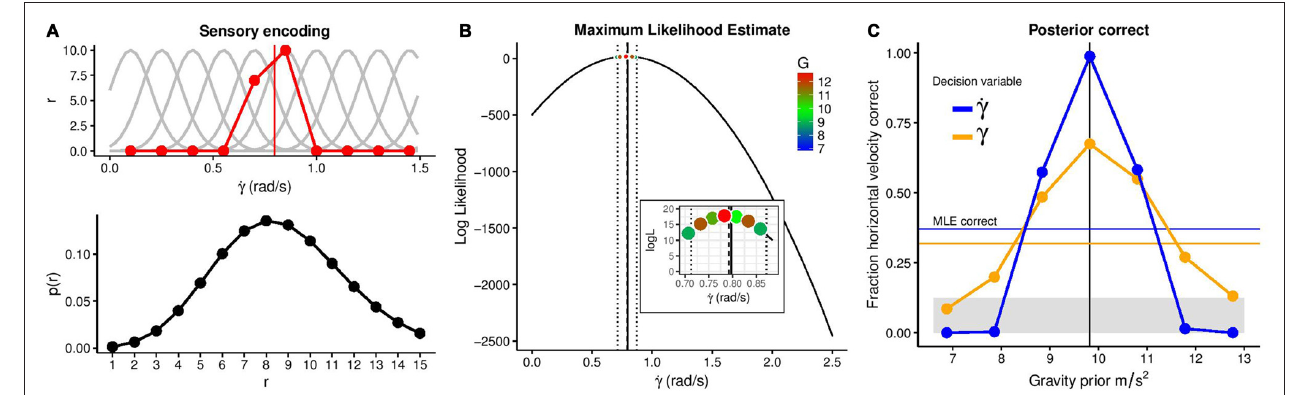
FIGURE 3 | Illustration of the benefits of a strong gravity prior. (A) The upper panel shows simulated tuning curves of neurons specialized for different rates of change of the elevation angle (light gray) together with neurons’ responses to the stimulus value of ˙ γ = 0.797 rad/s (red). The lower panel depicts the likelihood of different responses given this stimulation. (B) Maximum Likelihood Estimate of the stimulus value given the neural responses with a 10% error margin and the combinations of stimulus values that fall into this error margin. (C) Fraction of correct estimates of the horizontal velocity as a function of the gravity prior’s value for a Maximum Likelihood Estimation (thin blue line) and a Bayesian estimation based on the elevation angle (bold yellow line) or its rate of change (bold blue line) as decision variables. The gray area denotes chance